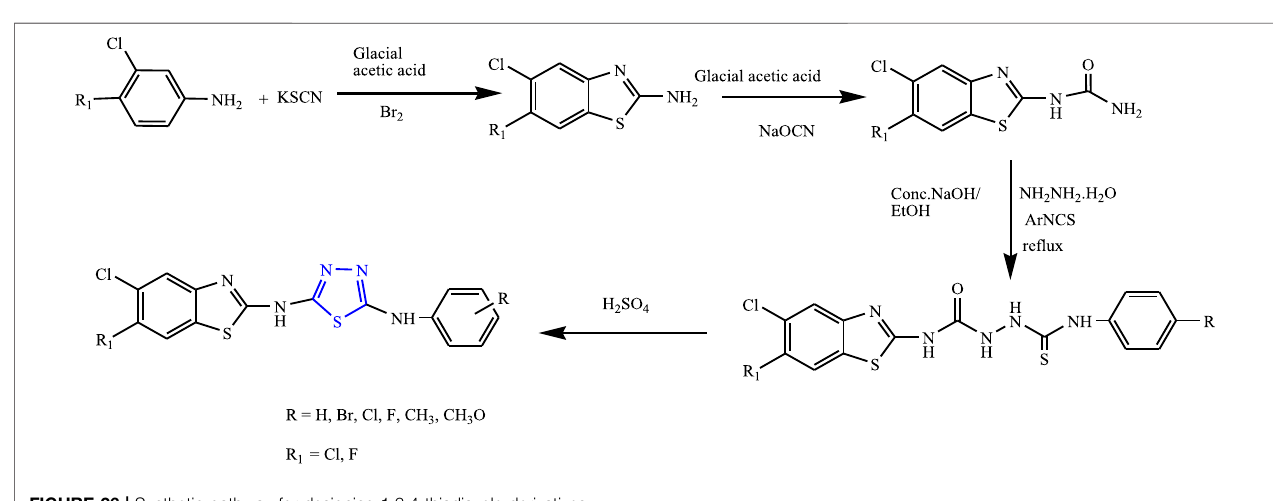
Frontiers in Chemistry |